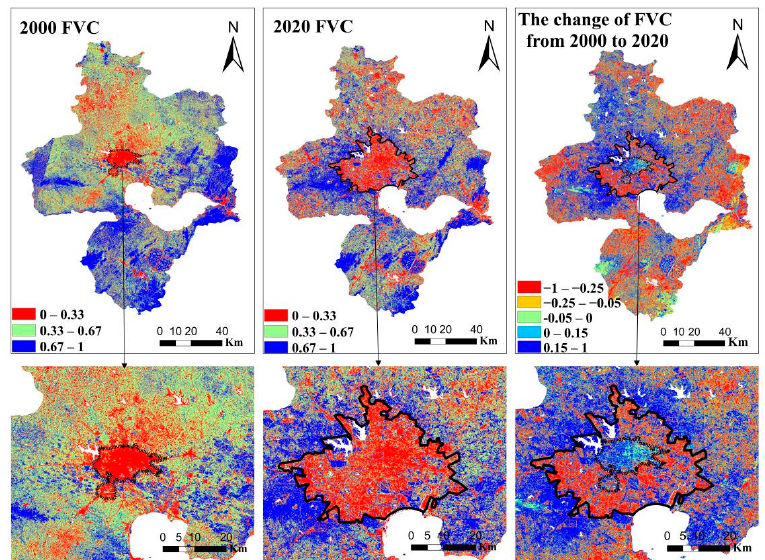
Figure 6. Spatio-temporal distribution variation in FVC in Hefei from 2000 to 2020: FVC values in 2000, FVC values in 2020, and FVC changes between 2000 and 2020 from global and local viewpoints, respectively.